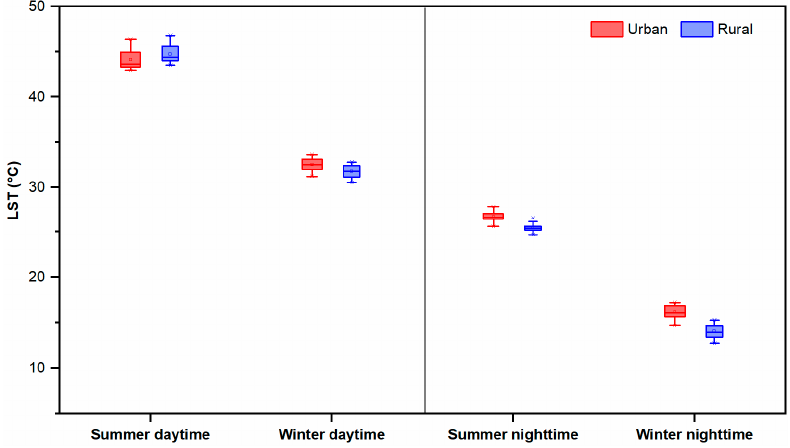
Figure 4. Daytime and nighttime seasonal variation (boxplot) of LST for Ahmedabad city and its surrounding rural area during 2003–2018. The upper and lower whiskers represent the maximum and minimum value of each specific LST dataset; the middle line is the LST average; the box upper and lower edges represent the third and first quartile of the data distribution.